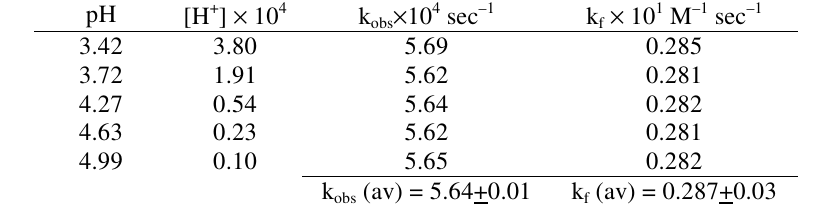
− = 2.0 × 10 -2 M Temperature = 30±0.1 o C and I = 0.1 M 4